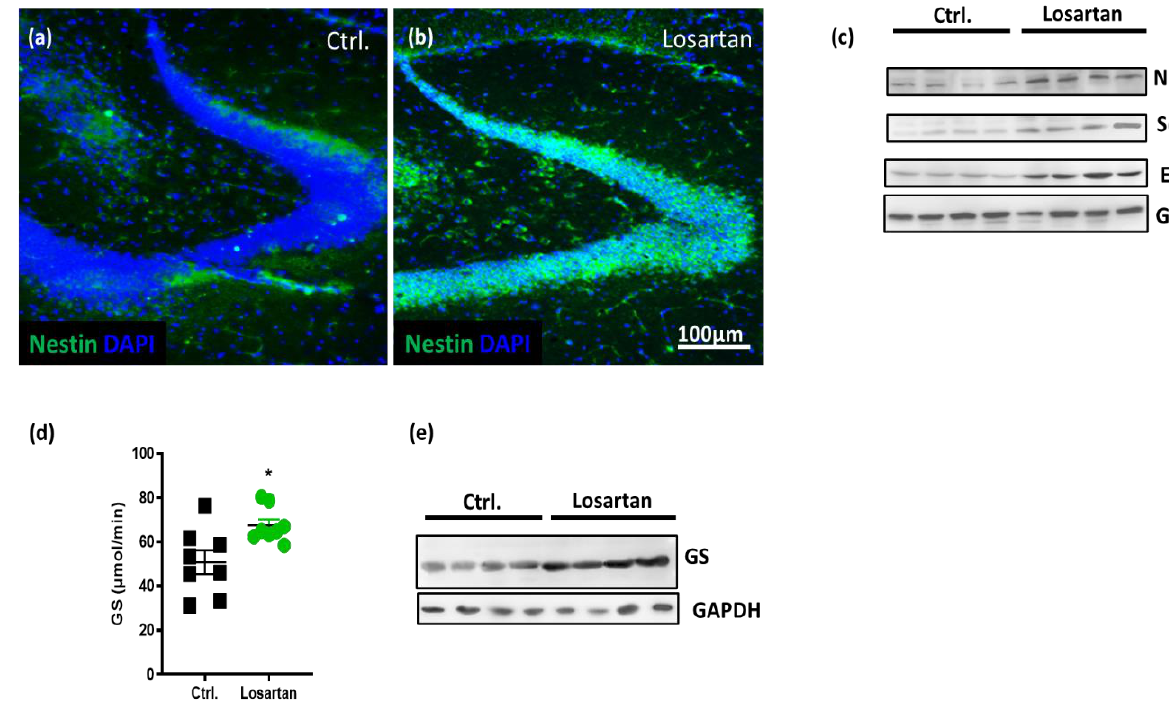
Figure 3. Losartan-mediated changes in neurogenesis and neuroprotection markers in APP/PS1 mice. ( a , b ) Expression of nestin (green) in the hilus and granular cell layer of the denate gyrus in brain sections of losartan vs. vehicle (Ctrl.) treated APP/PS1 mice. Cell nuclei are stained with 4 ´ ,6 diamidino-2-phenylindole (DAPI, blue), scale bar shown in ( b ) corresponds to the images shown in ( a ) and ( b ). ( c ) Cerebral content of Neuronal Differentiation 1 protein (NeuroD1), SRY-related HMG-box 2 (Sox2) and erythropoietin (EPO) assessed in brain homogenates of APP/PS1 mice ( n = 4) by Western Blot. ( d , e ) Enzymatic activity ( n = 8) and expression level of glutamine synthetase (GS) in brain homogenates of losartan and vehicle (Ctrl.) treated APP/PS1 mice ( n = 4). Statistical analysis in ( d ): t -test, * p < 0.05.